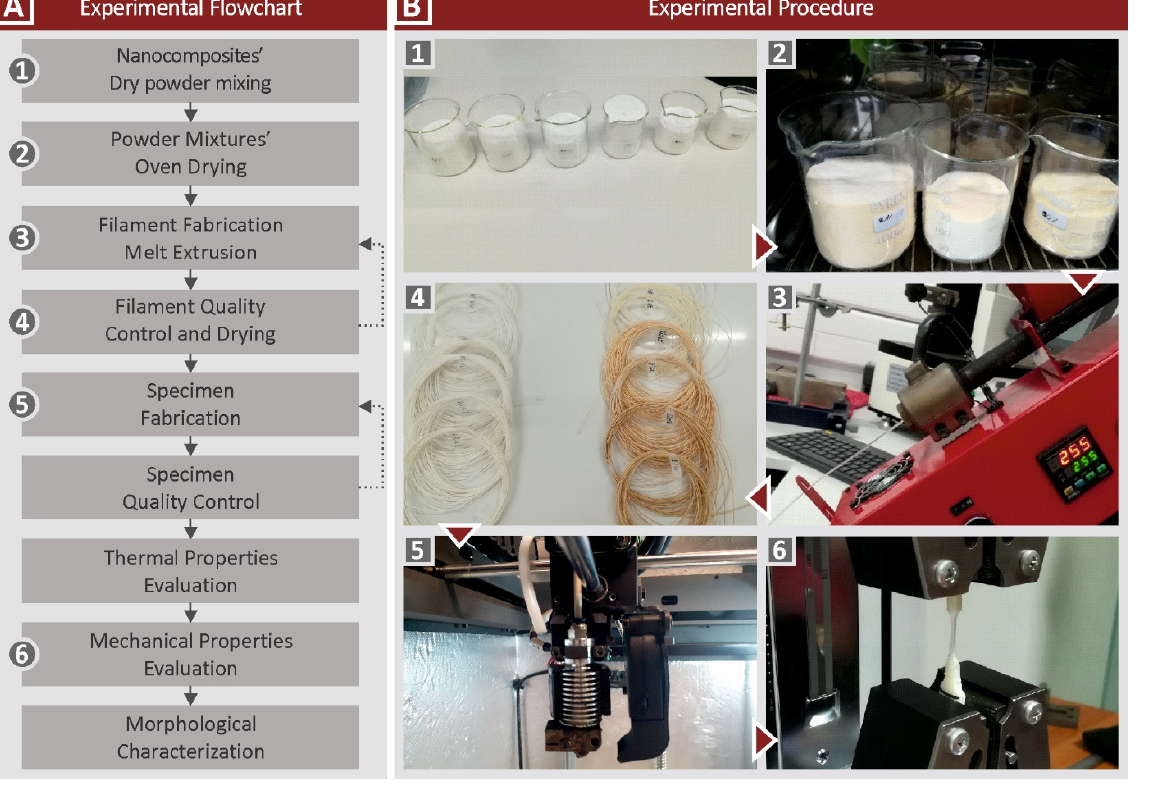
Figure 1. The overall followed workflow in this